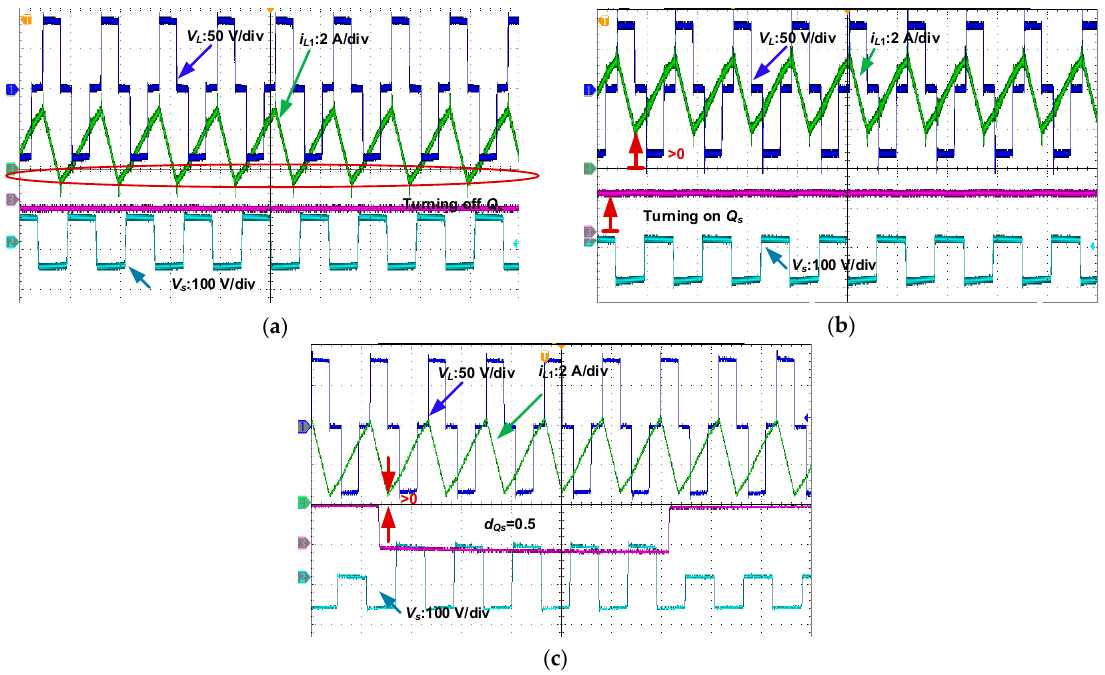
Figure 17. Waveforms of I L 1 , V p , and V s : L 1 is 51 μ H but the equivalent impedance R act changes ( a ) Q s stays OFF, R act reaches the maximum, part of I L 1 is below zero; ( b ) Q s stays ON, R act reaches the minimum, I L 1 is above zero; ( c ) Q s operates with d Qs = 0.5, I L 1 is above zero.